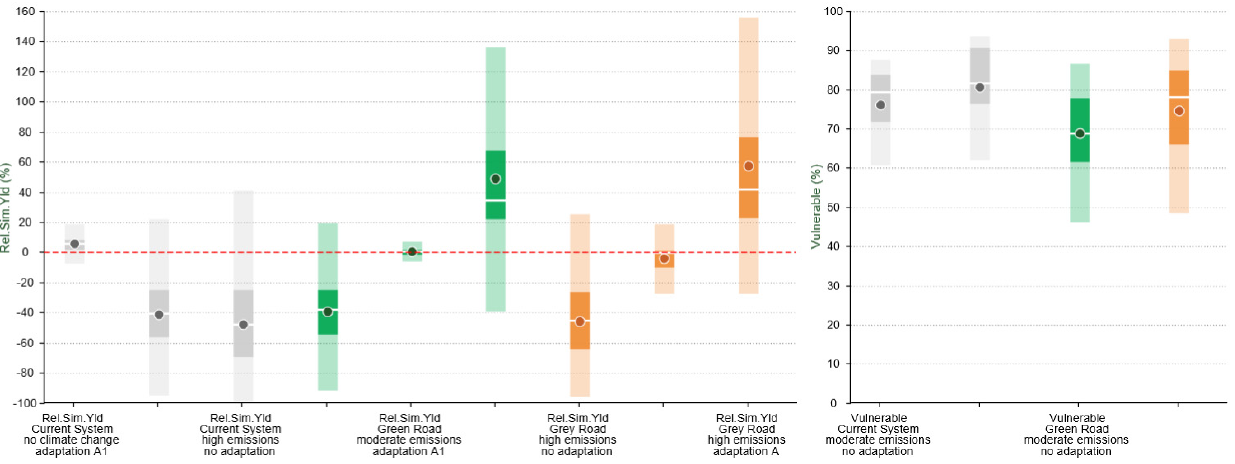
Figure 9. Pathways and modelling future scenarios to adopt climate-smart systems to minimize the vulnerability and promote environmentally friendly (green road) better cotton.